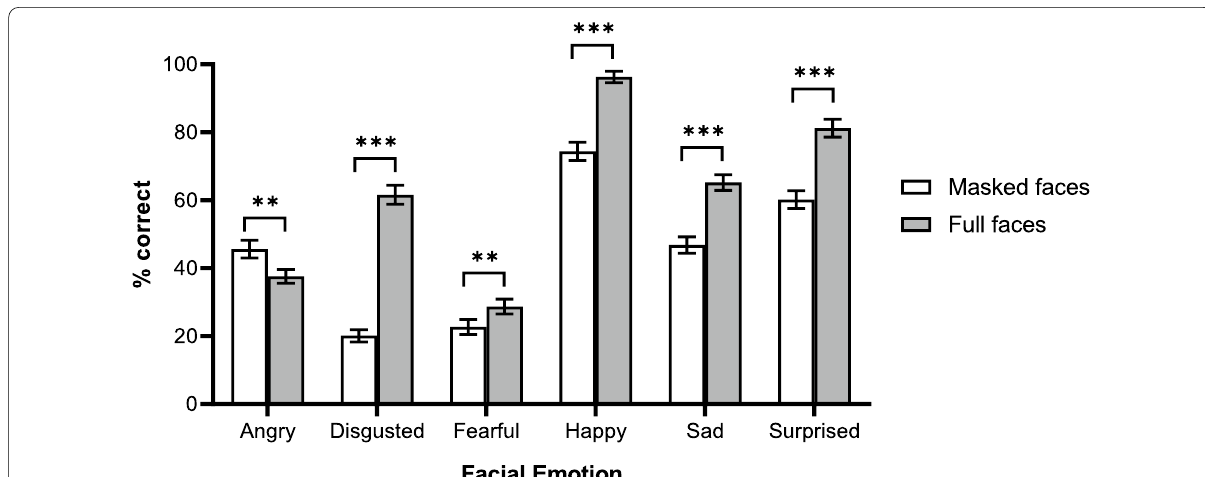
Fig. 6 Mean percentage scores for all emotion expressions for masked and full faces. Error bars represent standard error of the mean. Note: For the ease of illustration, the scores are presented in percentages instead of proportions. In this six-alternative force choice task, the chance level performance for is 16.67% instead of 50%. *** p < 0.001, ** p 0.01 ≤